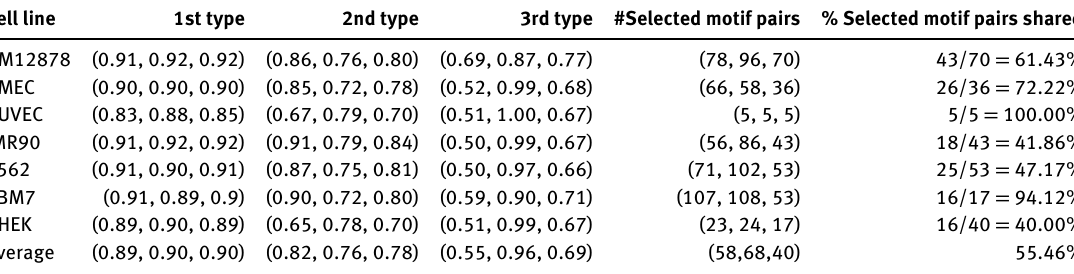
Table 3: The accuracy of motif pairs in distinguishing positive EP pairs from three types of negative EP pairs based on lasso. Cell